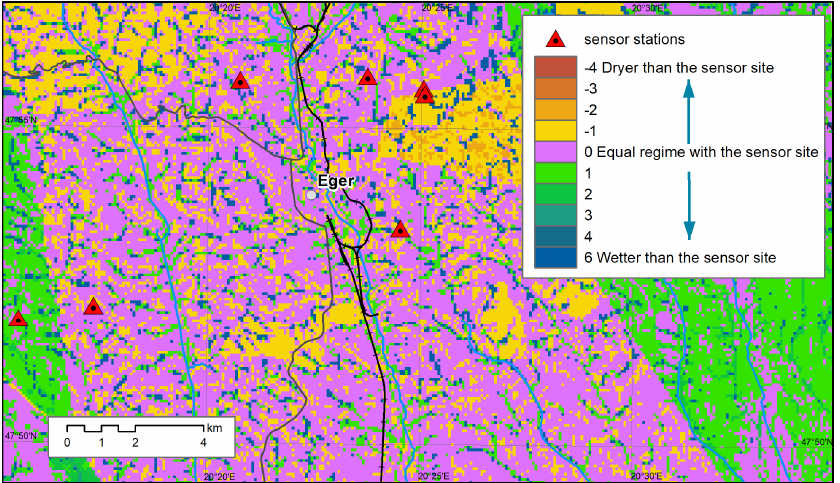
Figure 6. Differences in the morpho-pedotop moisture regime and moisture at sensor station sites (cut).